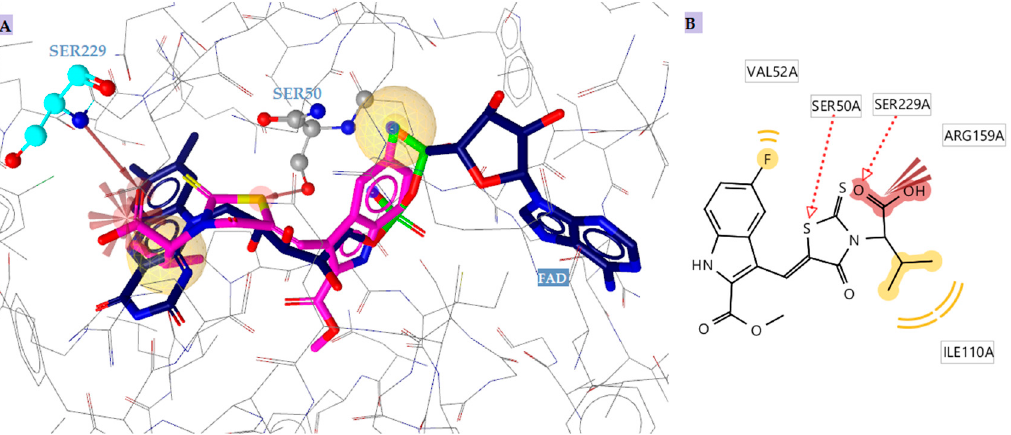
Figure 4. ( A ) Superposition of compound 8 (magenta) and FAD (blue) in E. coli MurB. ( B ) Docked conformation of the most active compound 8 in E. coli MurB. Red dotted arrows indicate H-bond and yellow spheres indicate hydrophobic interactions.